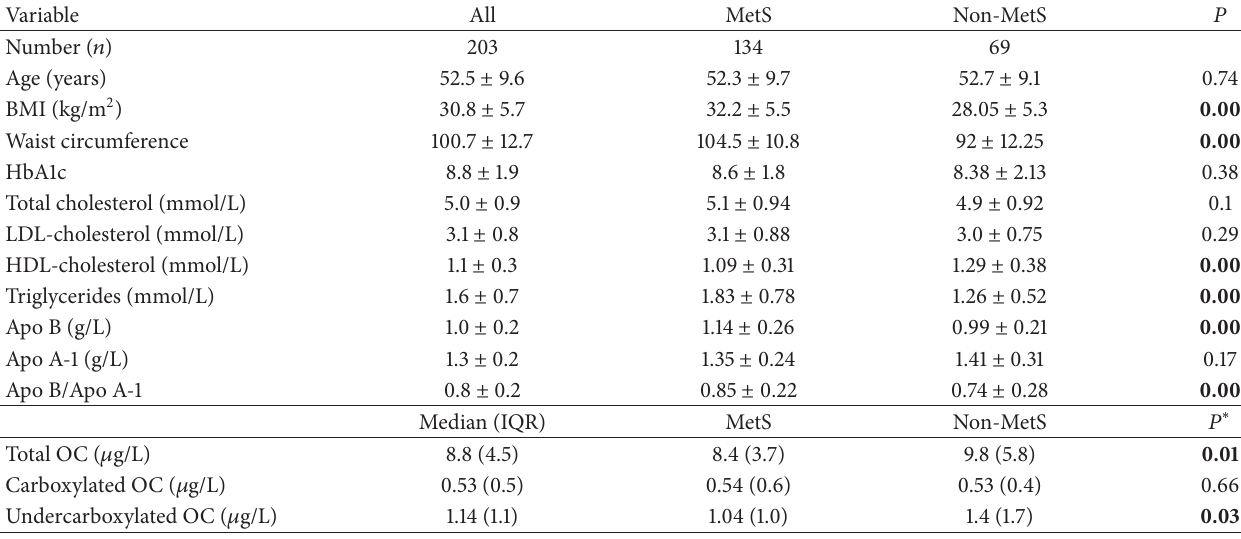
Table 1: Clinical and biochemical characteristics of the study population in all groups and based on the presence or absence of metabolic syndrome.